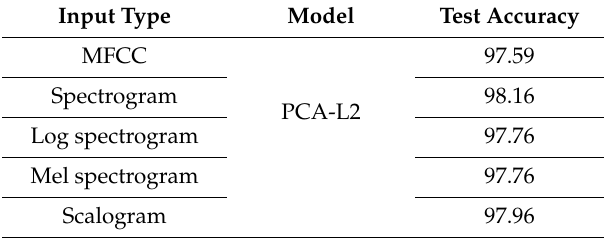
Table 2. Accuracies achieved by PCANet using time-frequency representations on PTB-ECG. Input Type.